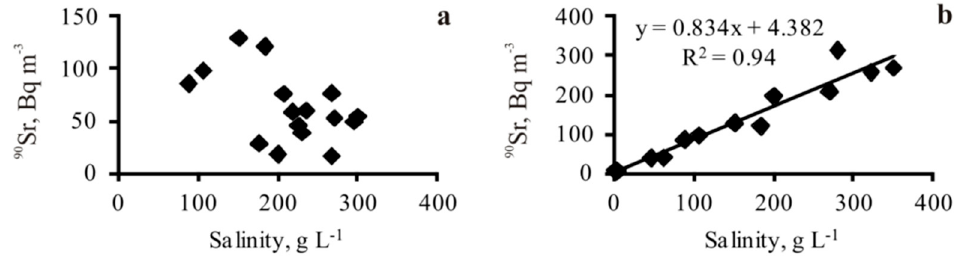
Figure 3. The dendrogram of similarity in relation “salinity— 90 Sr concentration” between samples taken from the studied Crimean lakes (a sample number was given in Table 1): ( a ) for all samples, ( b ) for samples taken from Lake Kirleutskoye, ( c ) for samples taken from Lake Kiyatskoye.